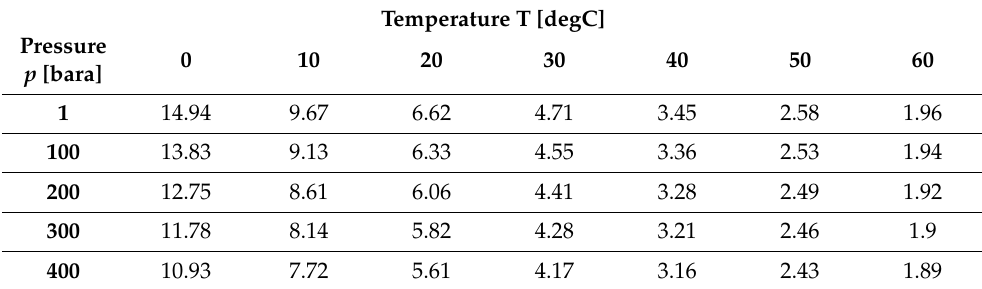
Table 2. Scaling tendency for barium sulphate of a B3 field produced water.